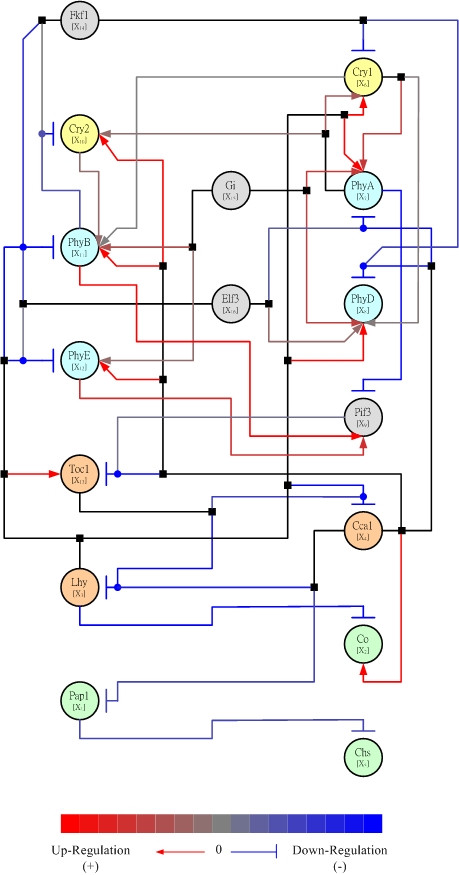
The pathway of circadian regulatory system of Arabidopsis thaliana according to the dynamic regulatory modeling in Table 1. The related genes are represented as ovals with different colors of light yellow (crytochrome), light blue (phytochrome), orange (biological clock genes), light green (some physiologically light-dependent downstream genes), and gray (other relevant genes not as target genes). There are three types of lines with colors of red (activation), blue (repression), and black. In addition to the black line representing the signal pipes from genes, the red lines are shown depending on the degree of activation whilst the blue lines are shown depending on the degree of repression. The black square symbol attached on the lines is the bifurcate node from the same pipe of signal. The circle symbol attached on the lines is the collecting nodes from different signal sources. The colored degree bar between activation and repression is also shown in the bottom of the figure.